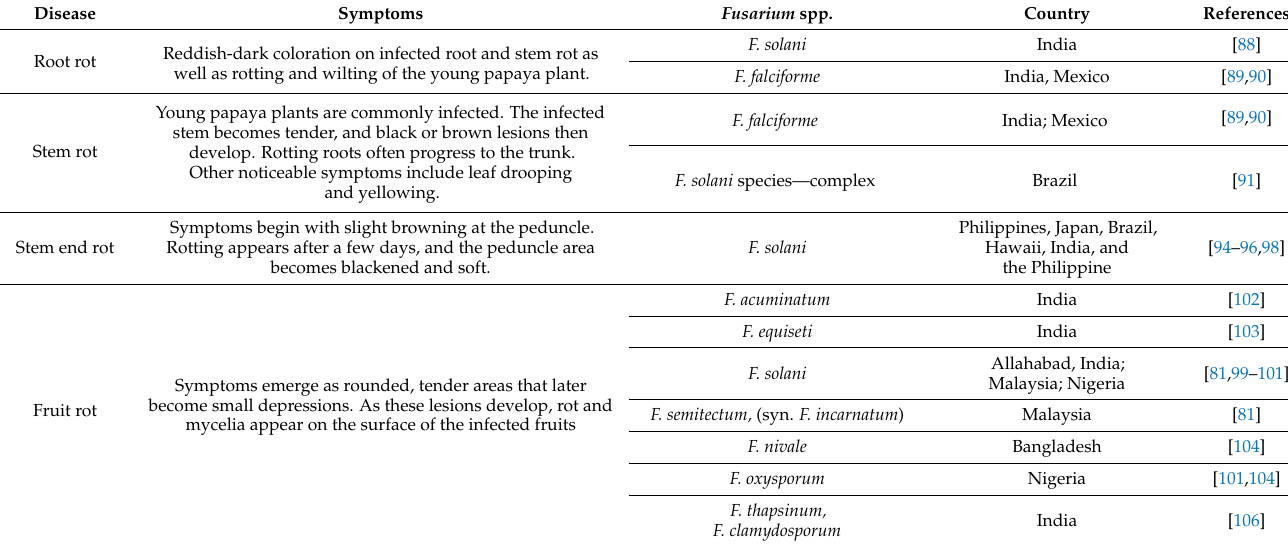
Table 2. Fusarium spp. associated with diseases of